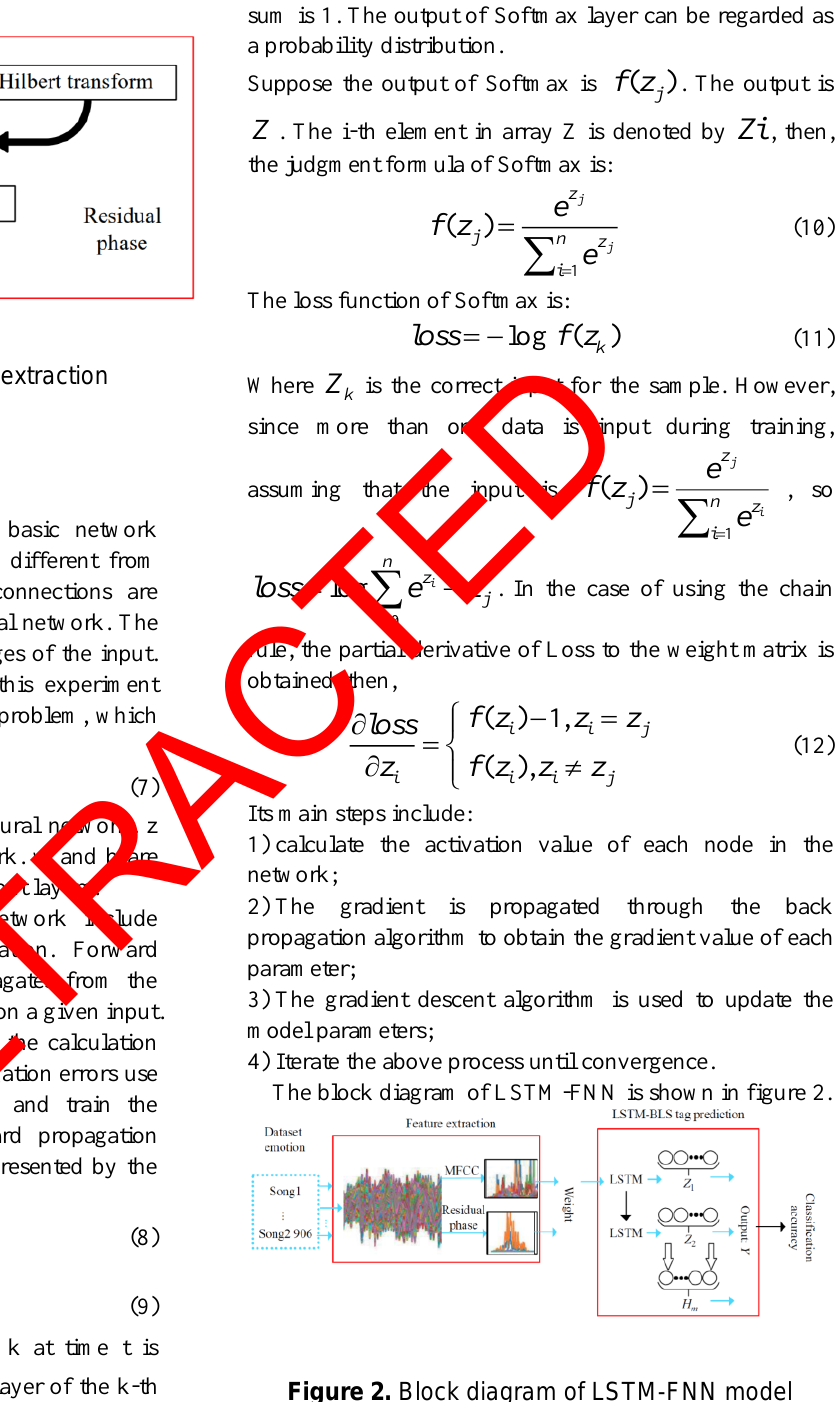
Figure 2. Block diagram of LSTM-FNN